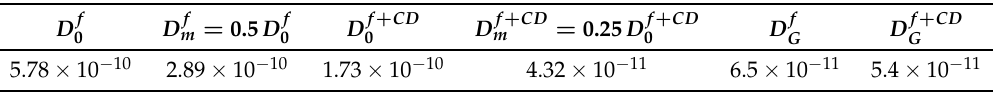
Figure 8. Differential ( A ) and integral release curves ( B ) for blank solution of furosemide with and without HP- β -CD. Continuous lines represent the imperfect mixing Model III predictions with + CD = 5.78 × 10 − 10 m 2 /s, D f = 1.73 × 10 − 10 m 2 /s and = 0.5 D f δ d = 1 mm, δ m = 45 µ m, D f , D f m 0 0 0 + CD = 0.25 D f + CD D f . ( A ) Differential release curves c p ( t i ) . ( B ) Integral release curves. M s dashed m t 0 curves with points represent the integral release curves as evaluated from experimental data and Equation (20) by assuming a perfectly mixed accepting compartment V res = 7.9 mL. Continuous lines represent the integral release curves as evaluated from the imperfect mixing Model III. Horizontal dot-dashed line represent the amount of drug M 0 initially loaded in the donor compartment. Table 2. Diffusivity values (m 2 /s) estimated from release data in Franz